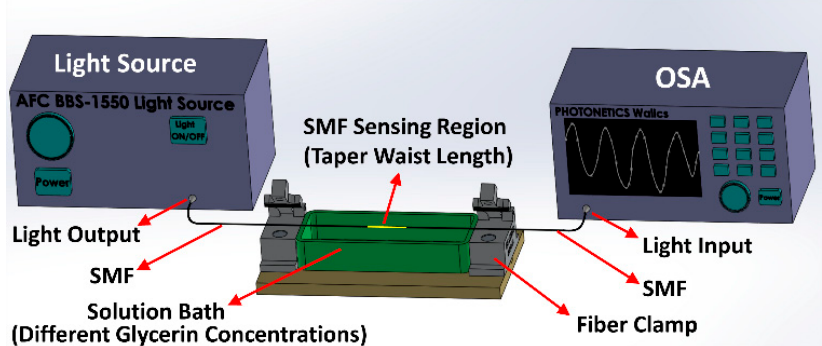
Figure 5. Schematic diagram of the experimental setup for refractive index characterization, OSA (Optical Spectrum Analyzer).